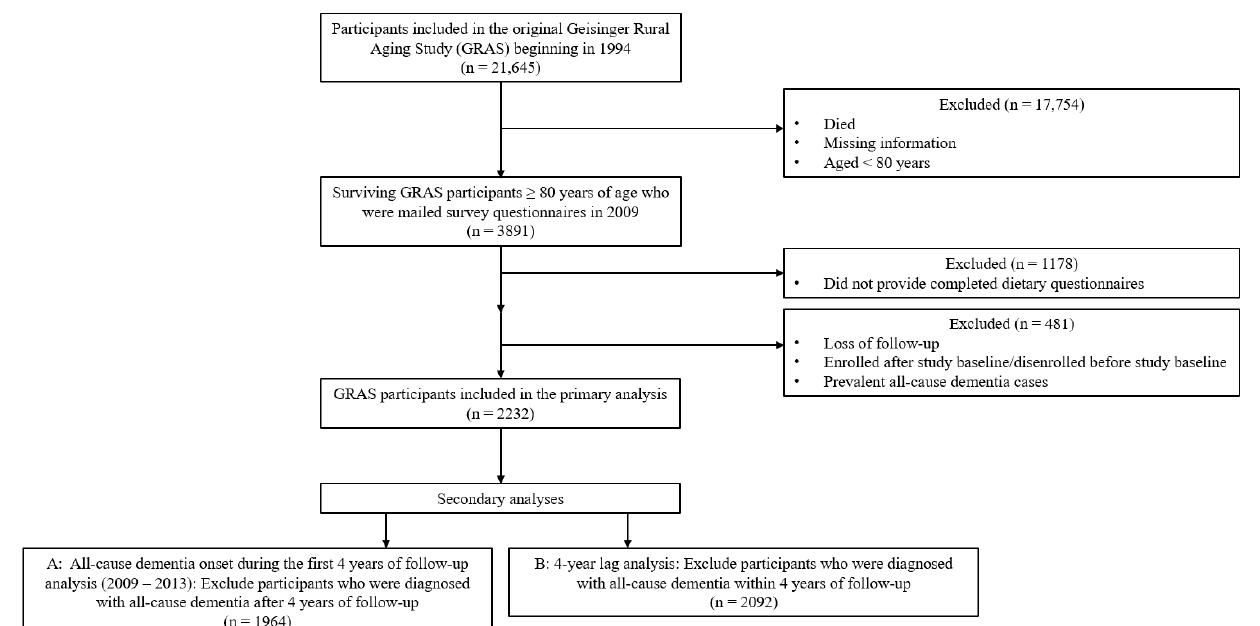
Figure 1. Flow Chart of Geisinger Rural Aging Study (GRAS) Participants. A total of 3891 surviving GRAS participants, 80 years and older, were mailed surveys in 2009. Among participants who received mailed surveys, 2232 participants returned completed dietary information, were not missing during follow-up, were not enrolled after the study baseline or disenrolled before the study baseline based on Electronic Health Record diagnosis data, and did not have prevalent all-cause dementia at baseline. Participants were followed through until 20 July 2021.